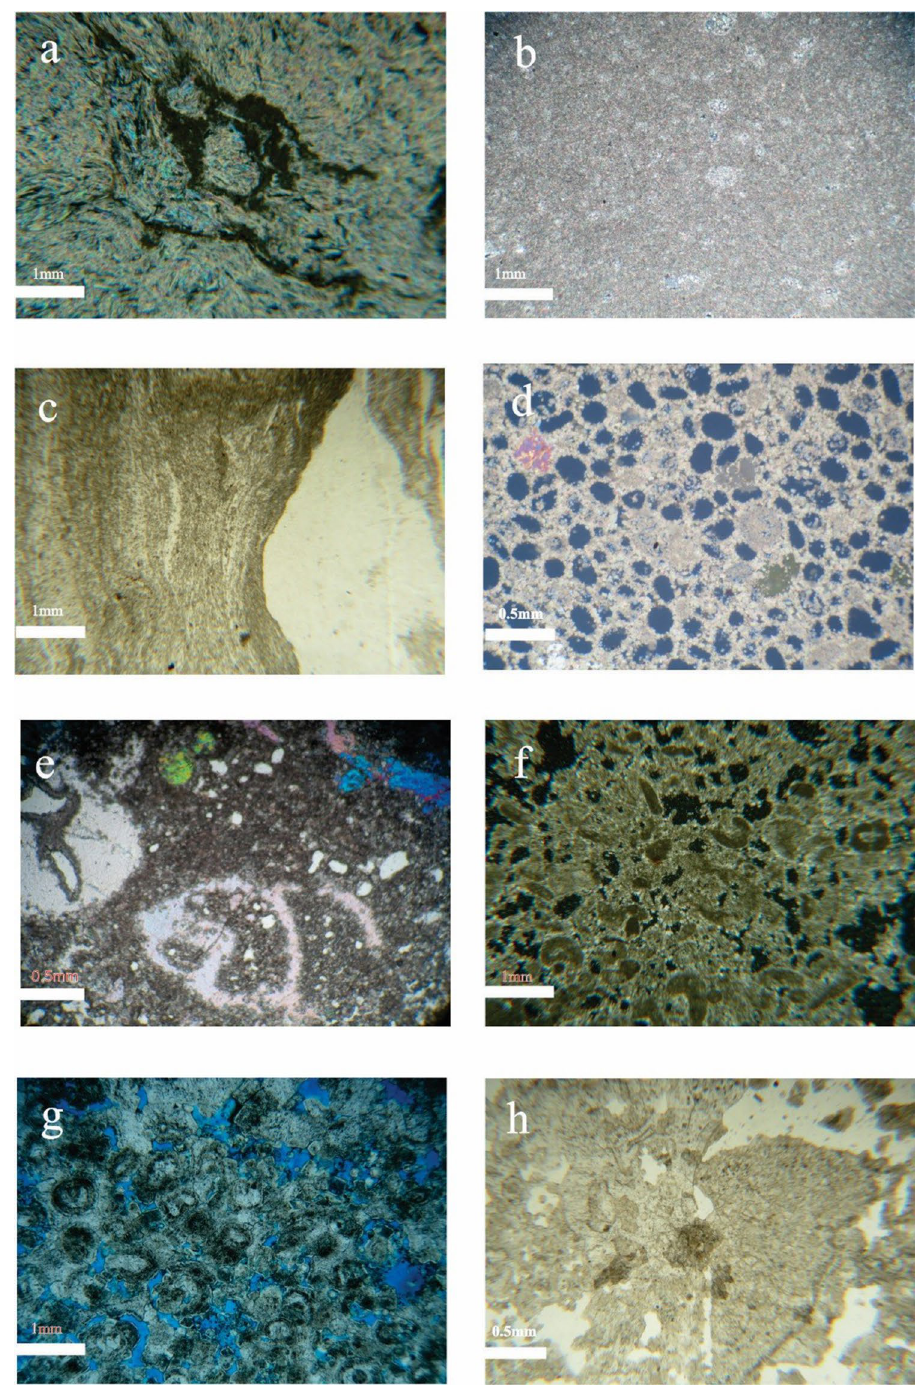
Fig. 4 Thin sections photo- micrographs illustrating main facies from the Arab Formation in the central of the Persian Gulf. a F1: anhydrite, b F2: dolomudstone missing